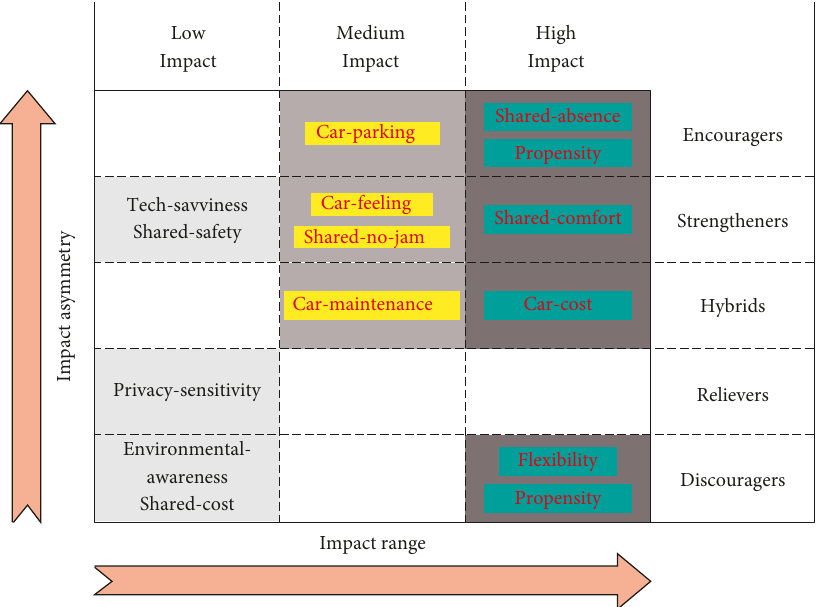
Figure 8: The comprehensive importance hierarchy of the post-COVID-19 intention